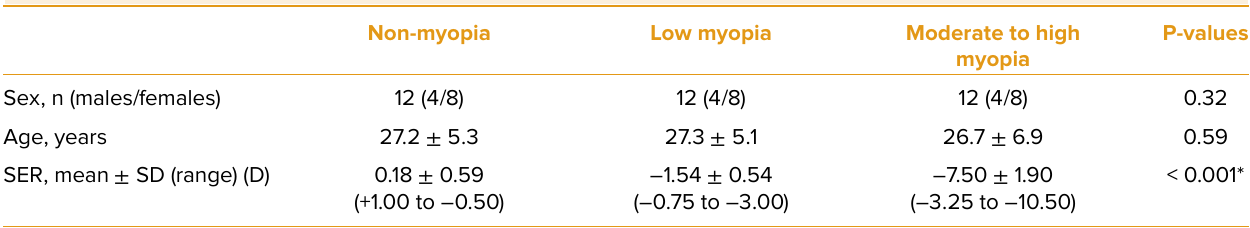
Table 1. Characteristics of study participants (n = 36 eyes)